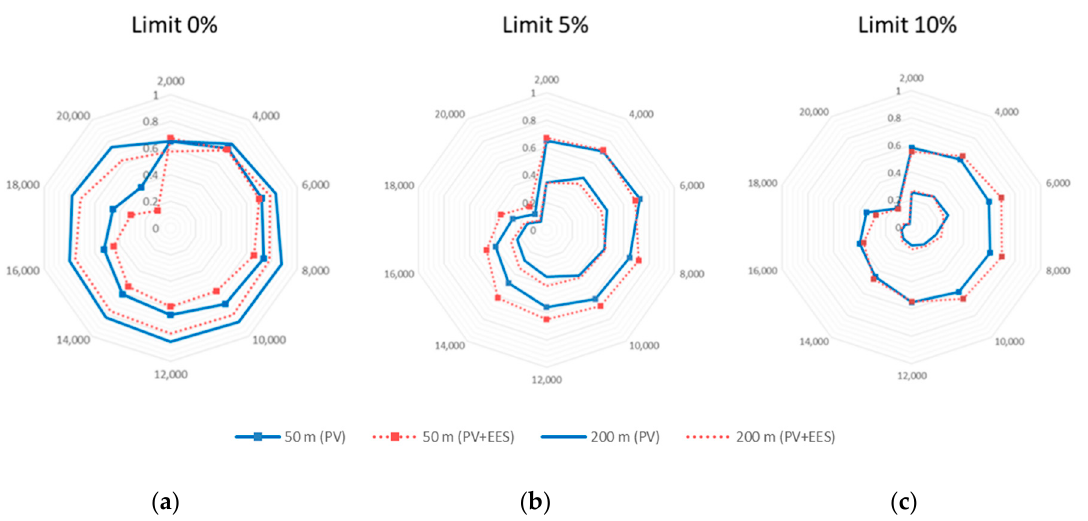
Figure 8. The utilization rate in both scenarios at di ff erent radius and when varying the installed Figure 8. The 𝑢𝑡𝑖𝑙𝑖𝑧𝑎𝑡𝑖𝑜𝑛 𝑟𝑎𝑡𝑒 in both scenarios at different radius and when varying the installed capacity on the urban territory when ( a ) limit = 0%; ( b ) limit = 5% and ( c ) limit = capacity on the urban territory when ( a ) limit = 0% ; ( b ) limit = 5% and ( c ) limit = 10%